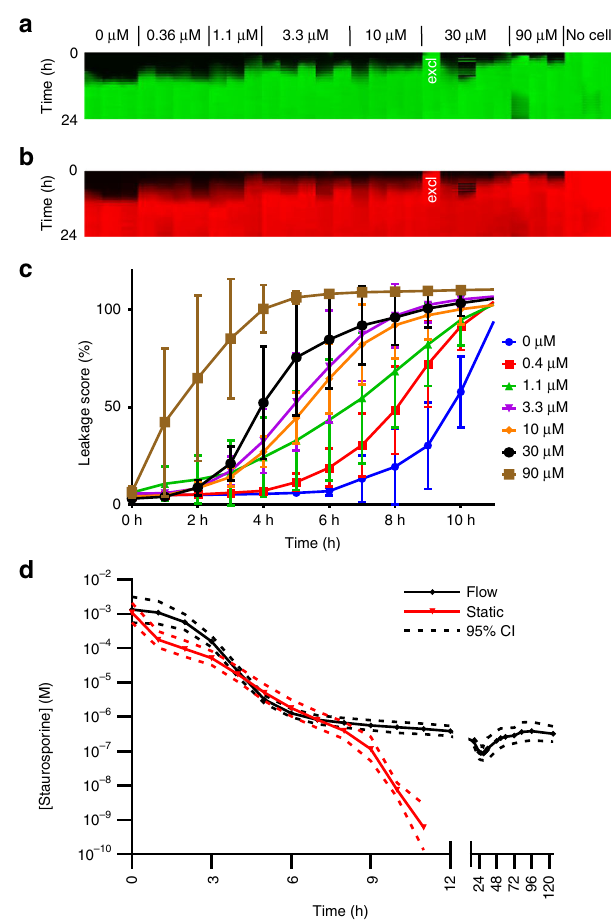
Fig. 5 Drug-induced loss of barrier integrity as a function of staurosporine concentration measured in real-time. a , b Array of fl uorescence micrographs of the gel region showing distribution of the 150 kDa FITC- Dextran ( a ) and 4.4 kDa TRITC-Dextran ( b ) over time and as a function of compound concentration; the OrganoPlate was continuously kept in an incubated automated microscope. Pictures were taken at 1 h intervals. One data point was excluded for the fact that the tube appeared leaky at the fi rst time point (marked with “ excl ” in white ). c The progression of the loss of barrier function over time shows that untreated controls lose barrier integrity at 6 – 8 h due to lack of fl ow. The plotted line is the mean of 3 – 5 technical replicate exposures and error bars depict the standard deviation. d EC 50 values over time for real-time measurement without fl ow and for measurement in intervals with fl ow induced between measurement (overlay with the graph of Fig. 4g). EC 50 values with and without fl ow are similar for the initial 8 h of